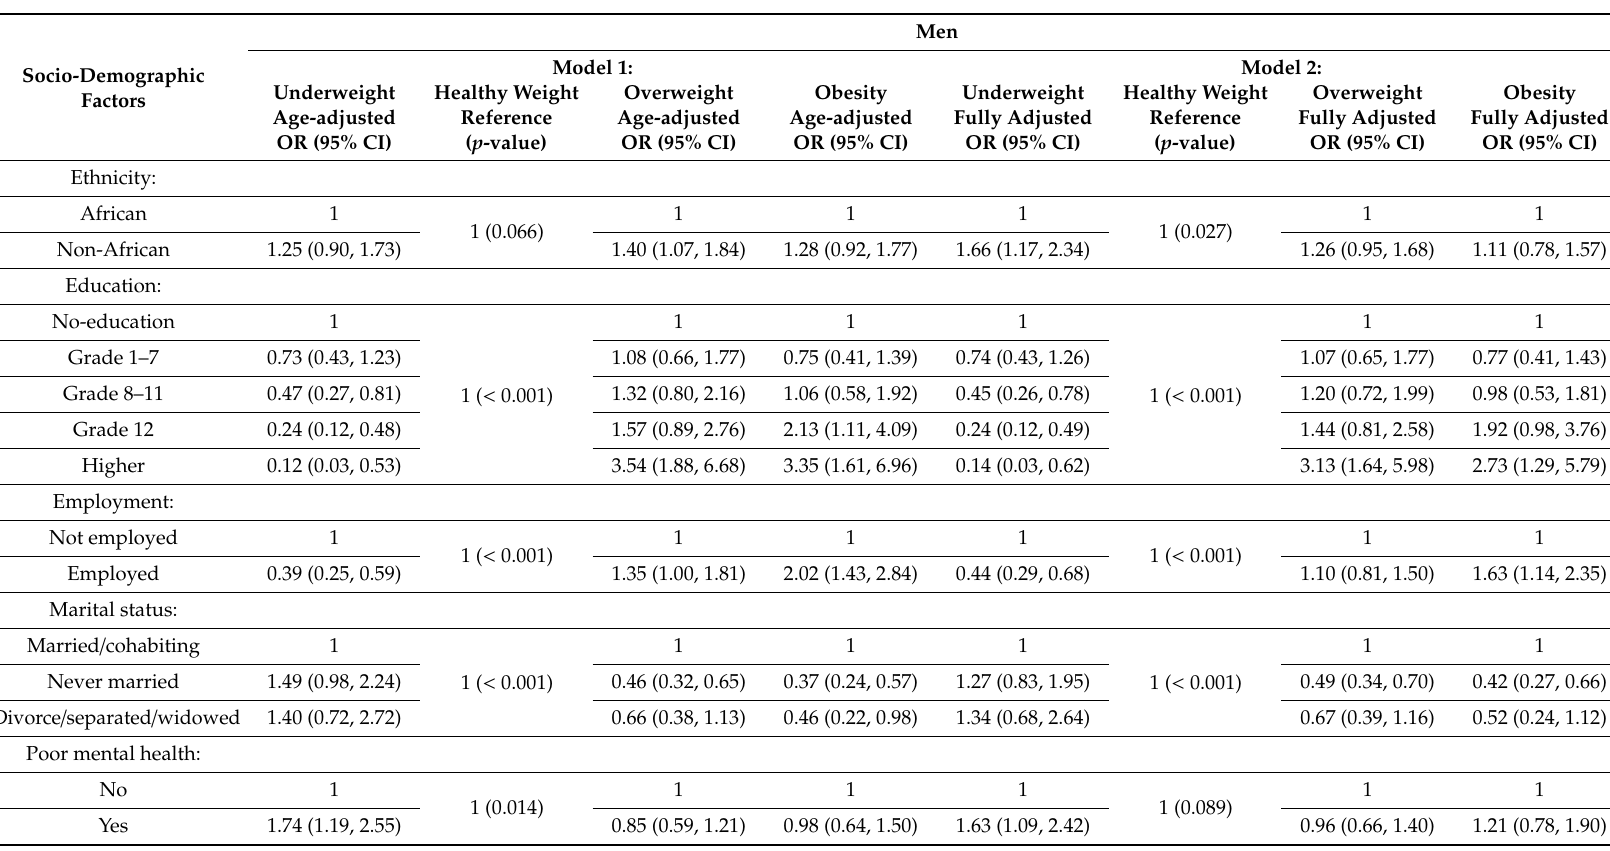
Table 4. Relative risk of underweight, overweight and obesity among 1655 men from the SANHANES study in 2012; by indicators of socioeconomic position (minimally and fully adjusted odds ratios from multinomial regression). Men Model 1: Model 2: Socio-Demographic Underweight Healthy Weight Overweight Obesity Underweight Healthy Weight Overweight Obesity Factors Age-adjusted Reference Age-adjusted Age-adjusted Fully Adjusted Reference Fully Adjusted Fully Adjusted OR (95% CI) ( p -value) OR (95% CI) OR (95% CI) OR (95% CI) ( p -value) OR (95% CI) OR (95%